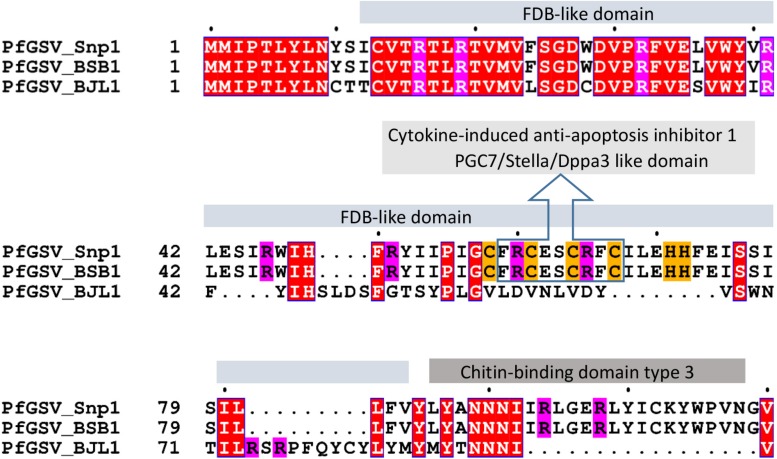
Deduced amino acid sequence alignment of proteins P13 and P11 from passion fruit green spot virus isolates Snp1, BSB1, and BJL1. Solids boxes on top of alignments label domains with remote identity in proteins P13, as identified by HHblits, HHpred, and Smart tools. White letters represent conserved amino acids across the three proteins. Magenta and mustard backgrounds highlight arginine (R), cysteine (C), and histidine (H) residues.